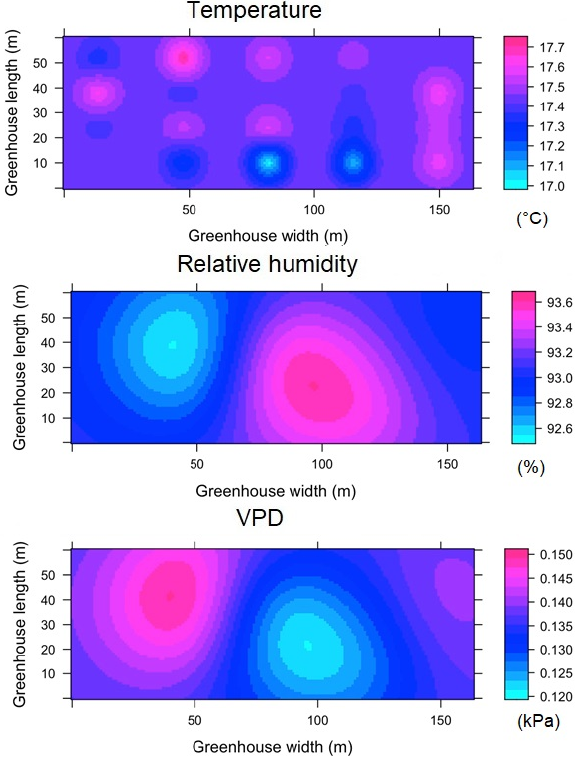
Figure A11. Spatial distribution predicted by kriging, for temperature, relative humidity and VPD in HGT1 and for ESRL 3.